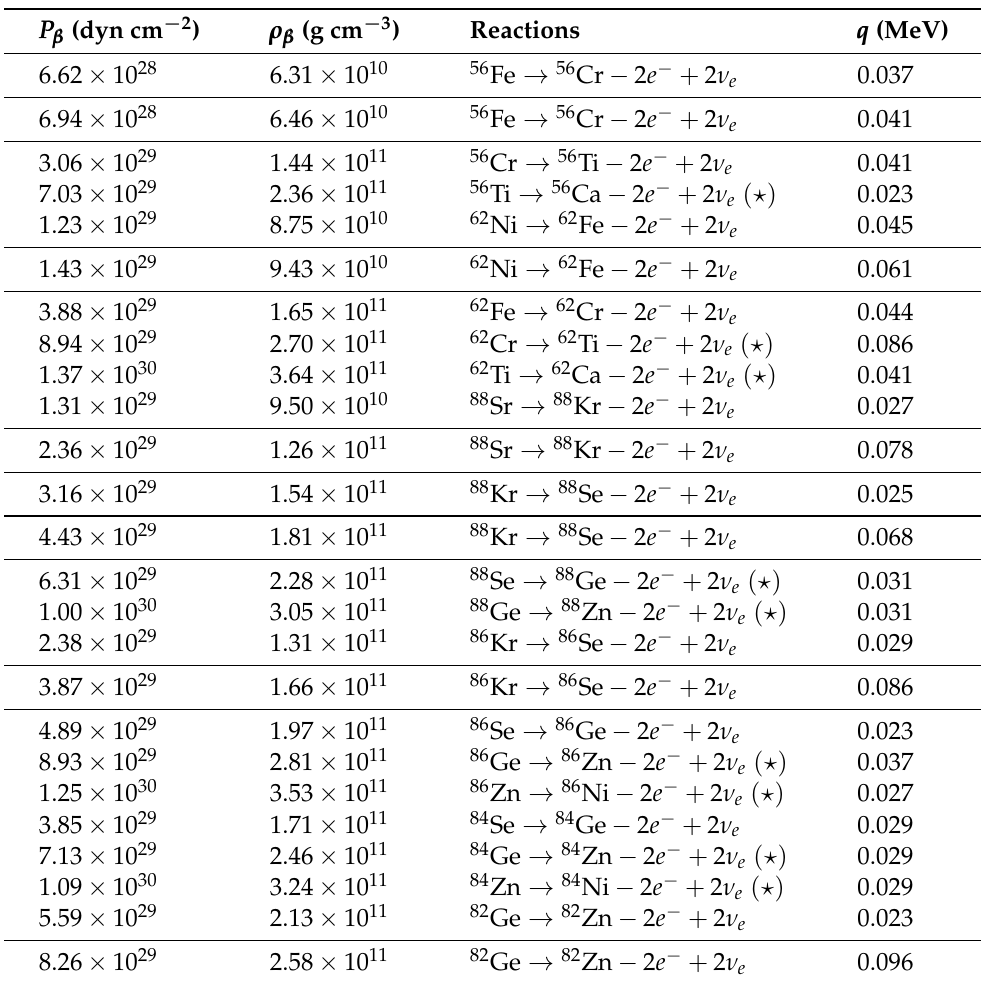
Table 1. Maximum possible heat released q per nucleon (in MeV) from electron captures in the outer crust of a magnetar with B (cid:63) = 2000. The pressure P β (in dyn cm − 2 ) and density ρ β (in g cm − 3 ) at which electron capture occurs are given considering ground-state-to-ground-state transitions (first line of reaction) and ground-state-to-excited-state transitions (second line). The initial composition was taken from [21]. The symbol ( (cid:63) ) is used to distinguish reactions for which theoretical atomic masses were